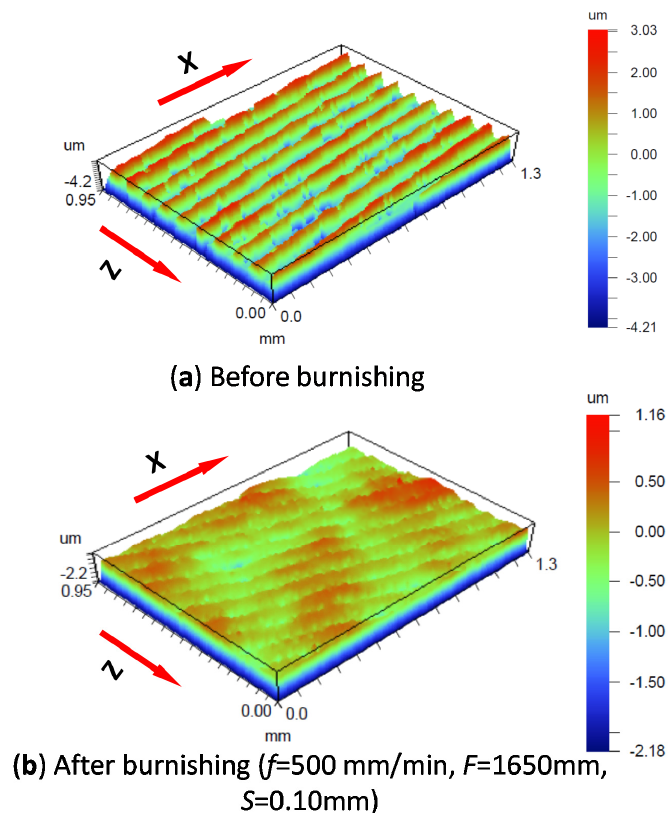
Figure 10. Surface topography ( a ) before and ( b ) after burnishing, measured by an optical profilometer at F = 1650 N, f = 300 mm/min, and S = 0.10 mm.